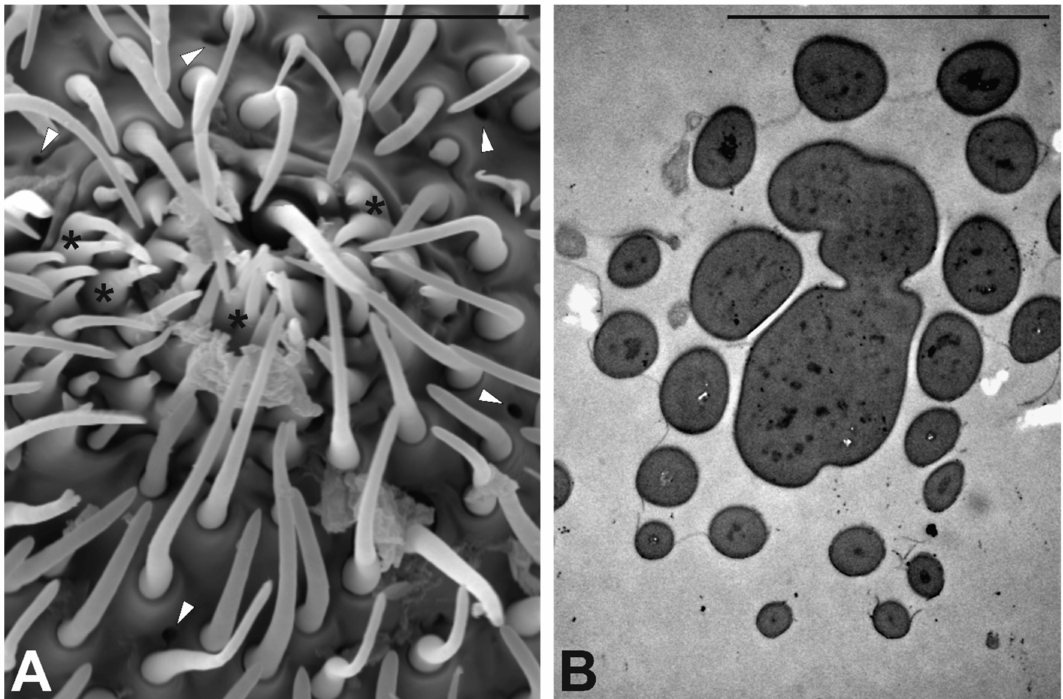
Figure 8. ( A ) SEM micrograph showing the apical part of the last antennomere (F6) in S. zeamais female. Several cuticular structures (*) are grouped around the tip, together with numerous sensilla. Several cuticular pores (white arrowheads) are present. ( B ) TEM micrograph showing a cross section of the antenna tip: The structures are made of solid cuticle without sensory neurons associated. Bar scale: 5 µ